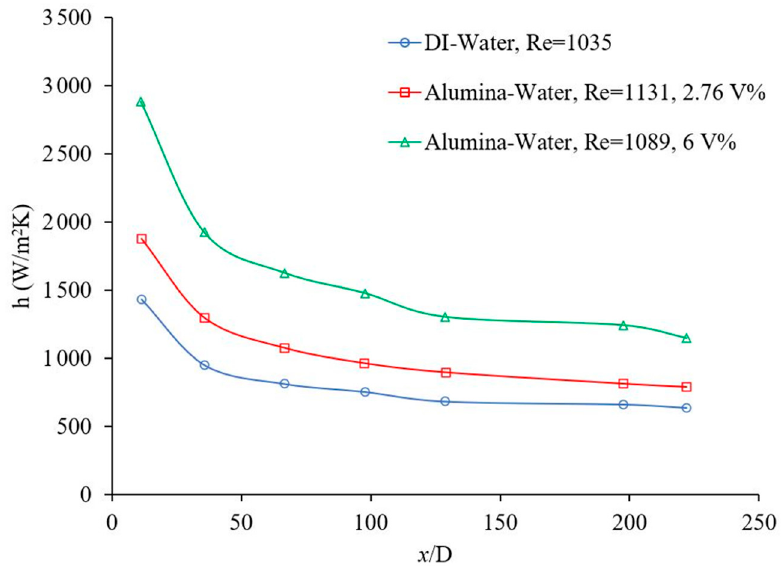
Figure 1. Effect of volume concentration on heat transfer coefficient, Rea et al. [14].